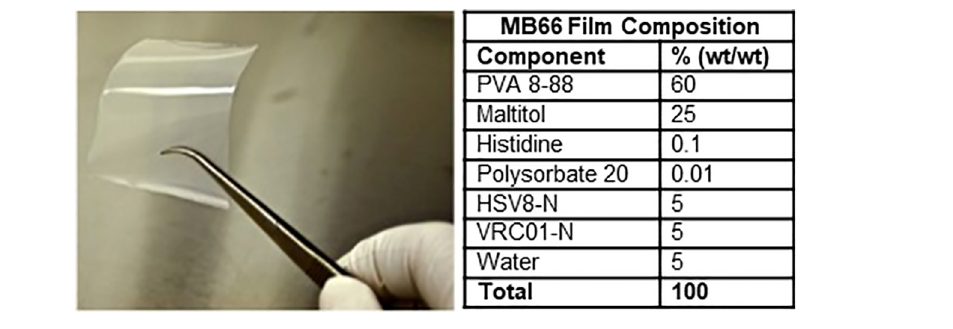
Fig 1. MB66 film example and